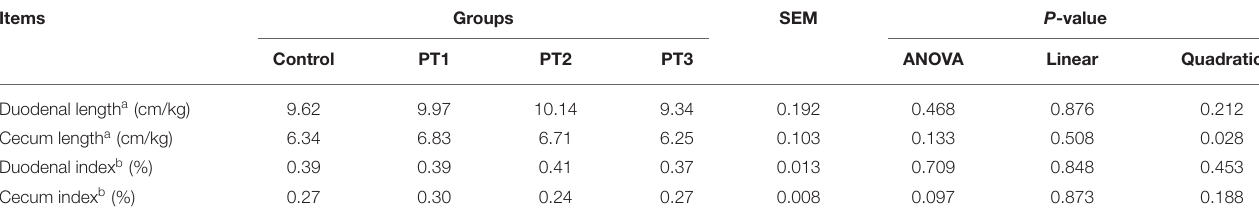
TABLE 4 | Effects of Plotytarya strohilacea Sieb. et Zuce tannin on correction length and index of broilers intestines at 42 days of age. Items Groups